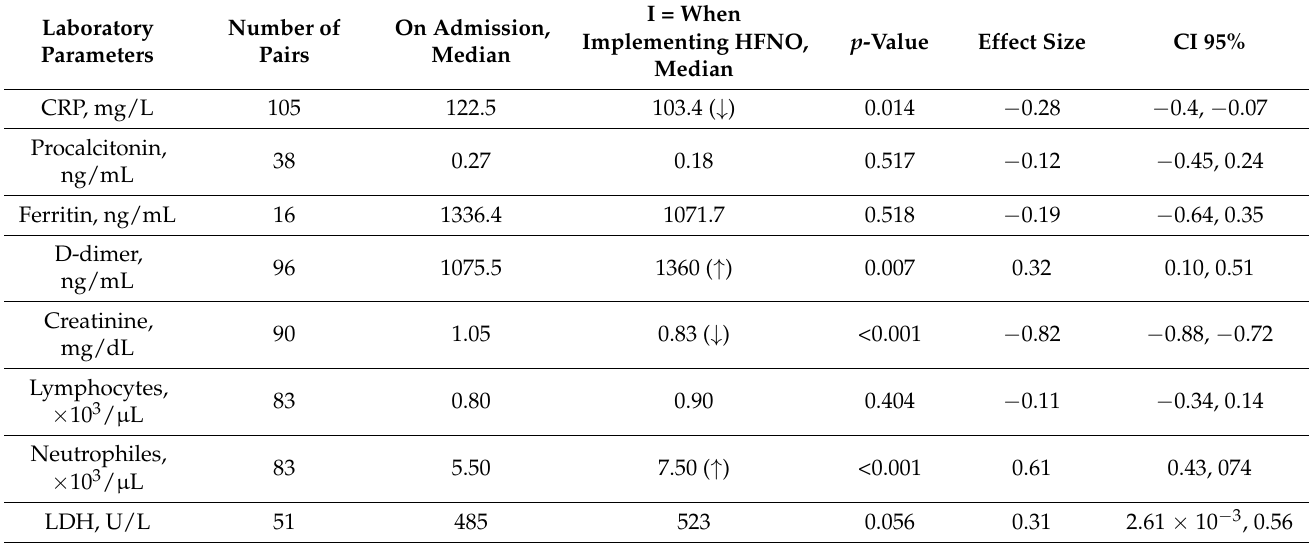
Table 6. Comparison of lab test results on hospital admission and on the day of administering HFNO, Wilcoxon test for paired data. Effect size was calculated using rank-biserial